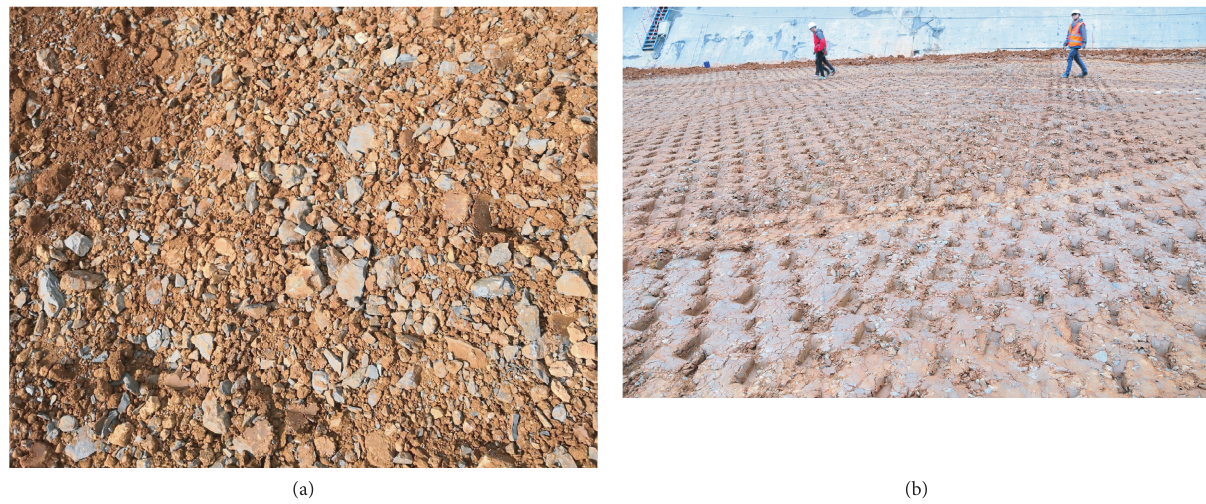
Figure 9: Photograph of gravelly soil before and after being compacted. (a) Loose gravelly soil. (b) Compacted gravelly soil.